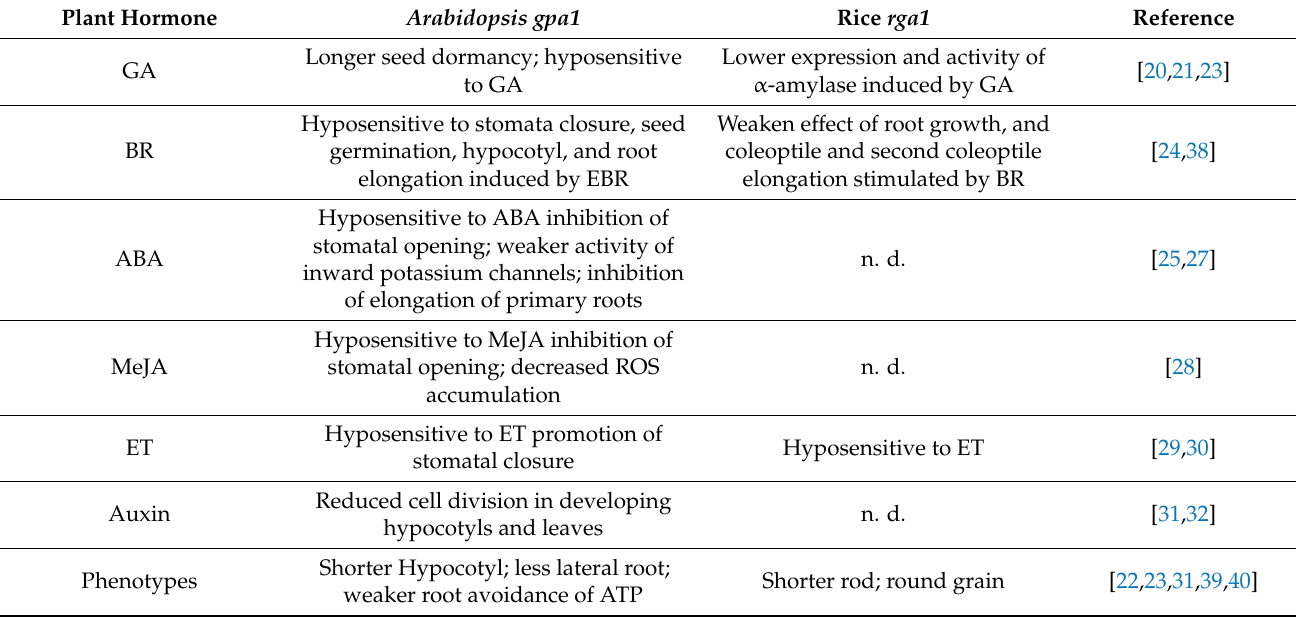
Table 1. Response to plant hormones and characteristic morphological traits of G α mutants. Plant